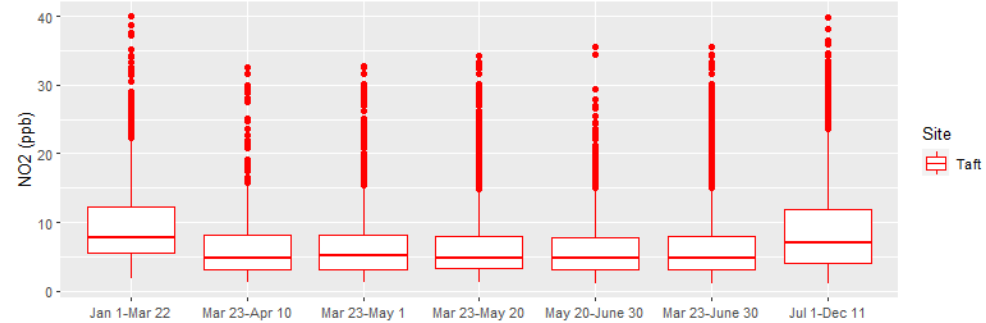
Figure 10. Boxplots of hourly CO during each time period of interest during 2020 at the Near Road and Taft sites.